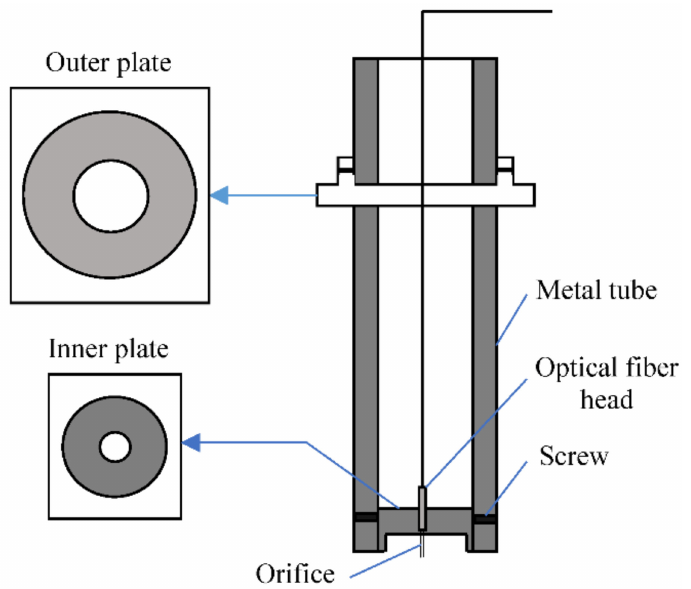
Figure 16. Design schematic diagram of a radiation shading cylinder